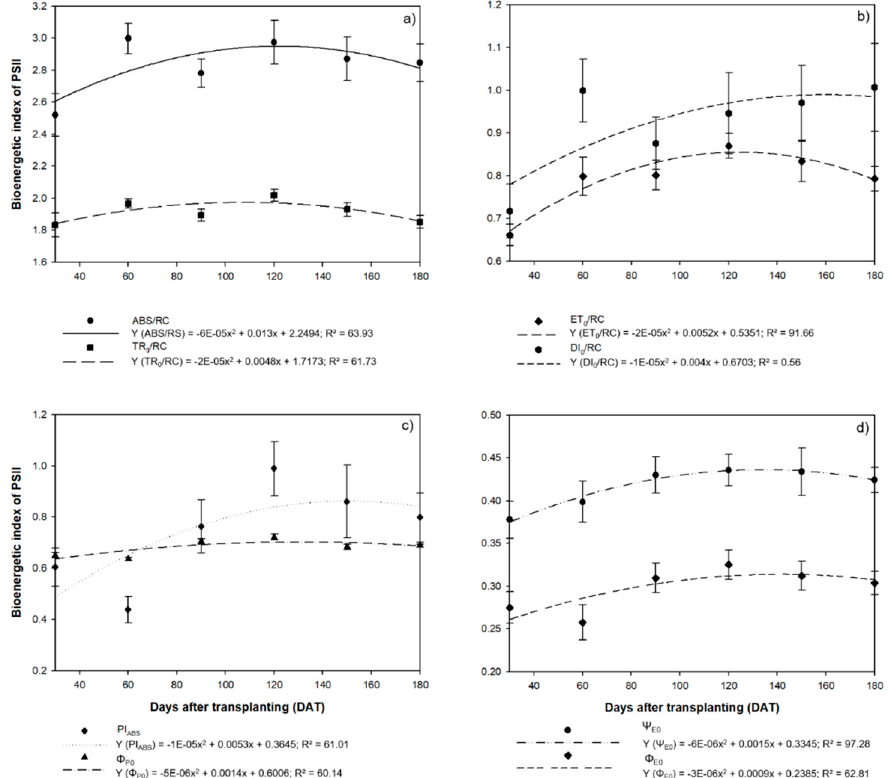
Figure 7. Parameters of chlorophyll a fluorescence observed in the leaves of the seedlings of Hymenaea courbaril L. cultivated in a hydroponic system and sampled at 30-day intervals across their initial development (30, 60, 90, 120, 150, and 180 days after transplantation): ( a ) the absorption flux energy per active reaction center (ABS / RC) and the energy flux captured by each reaction center (TR 0 / RC); ( b ) the electron transport flux per reaction center (ET 0 / RC) and the specific flux of the dissipation of energy at the level of the chlorophylls of the antenna complex (DI 0 / RC); ( c ) photosynthetic performance index (PI ABS ) and the maximum primary photochemical quantum yield ( φ P0 ); ( d ) the probability that a captured exciton will move an electron along the electron transporter chain ( Ψ E0 ) and the quantum yield of electron transport ( Φ E0 ). Marker bars = SE (observed for eight